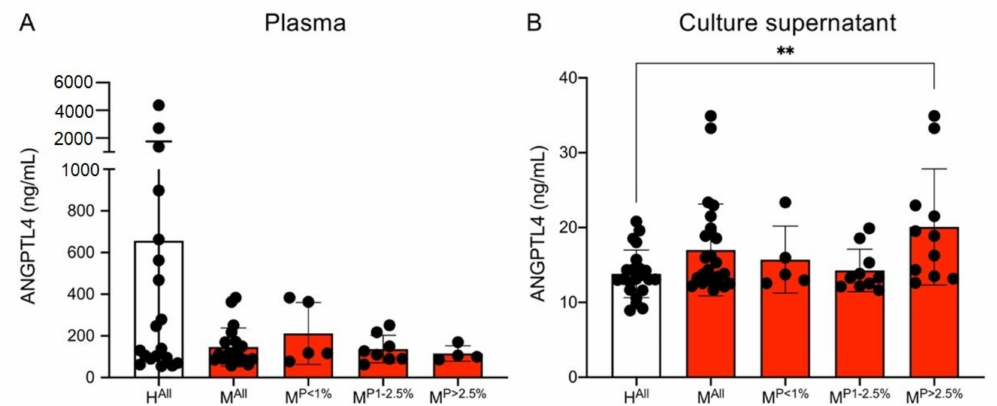
Figure 4. Amount of ANGPTL4 in plasma ( A ) and culture supernatants ( B ) of endothelial cells (HBEC-5i) co-incubated with plasma from malaria patients and healthy individuals. Statistical analyses were performed using the Mann–Whitney U test (** p < 0.01) (Supplementary Table S6). Abbreviations: Healthy controls (H All ); malaria patients (M All ); malaria patients with a parasitaemia < 1% (M P<1% ), 1–2.5% (M P1 − 2.5% ) and >2.5% (M P>2.5%